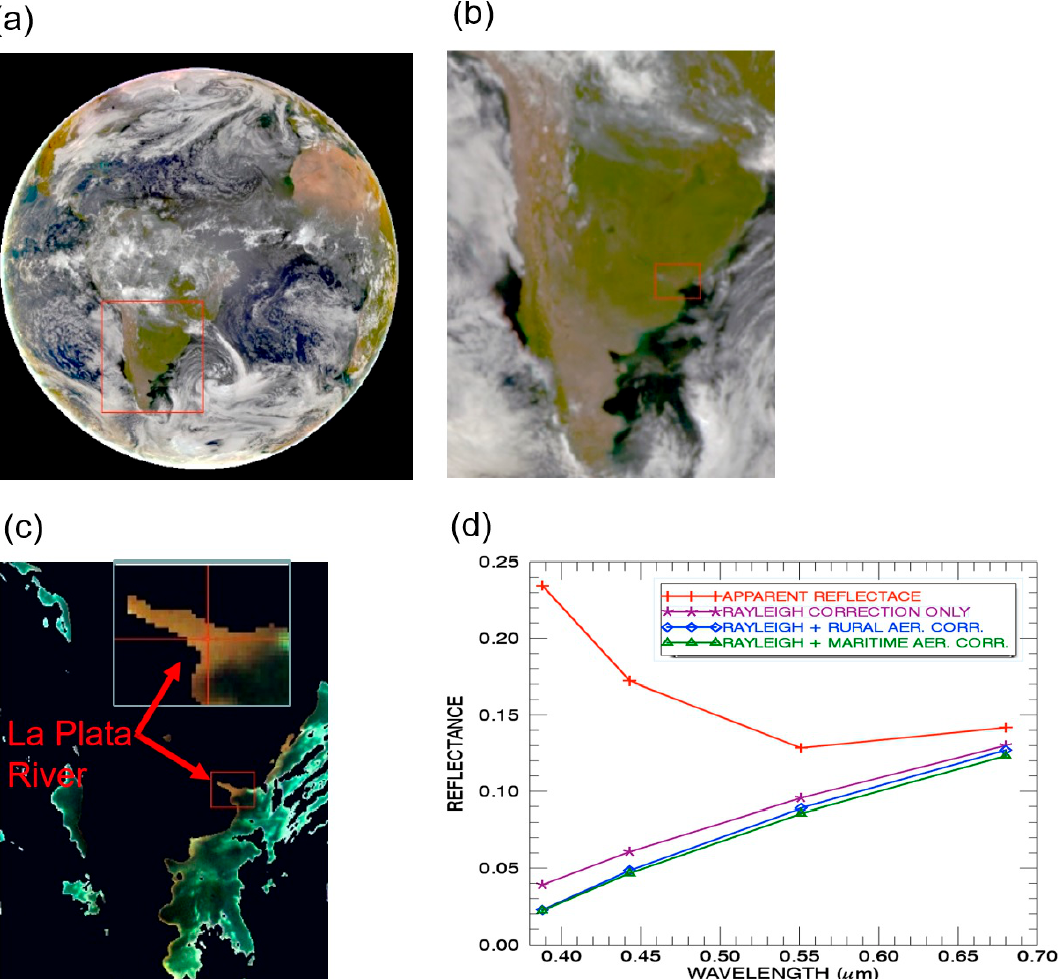
Figure 2. ( a ) The sunlit full disk color image processed from three atmosphere corrected EPIC channel (Red: 680 nm; Green: 551 nm; Blue: 443 nm) images acquired on 13 March 2017 at UTC 1442; ( b ) The portions of color image over S. America; ( c ) The portions of color image of water surfaces over S. America after masking out land and cloud pixels; ( d ) Spectral reflectances as a function of wavelength for one turbid river water pixel located at the center of the small rectangle outlined in ( c ). In ( d ), the line marked with ‘+’ is the top of atmosphere apparent reflectance curve. The lines marked with ‘*’, diamond, and triangle are the retrieved water leaving reflectances for the Rayleigh only, Rayleigh plus rural aerosol model, and Rayleigh plus maritime model corrections, respectively. The inlet in ( c ) shows an enlarged portion of La Plata